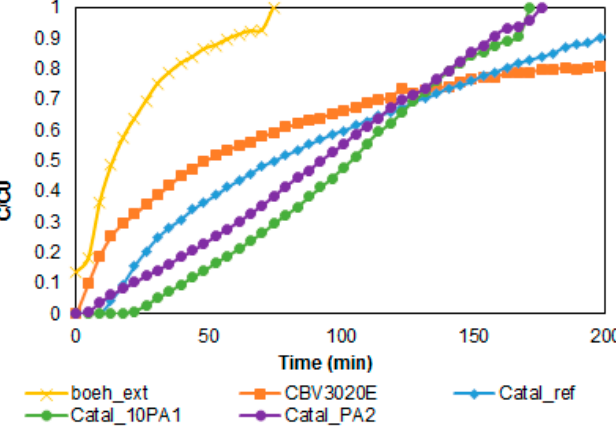
Figure 7. Adsorption breakthrough curves of toluene (400 ppm in 100 mL/min Ar flow).